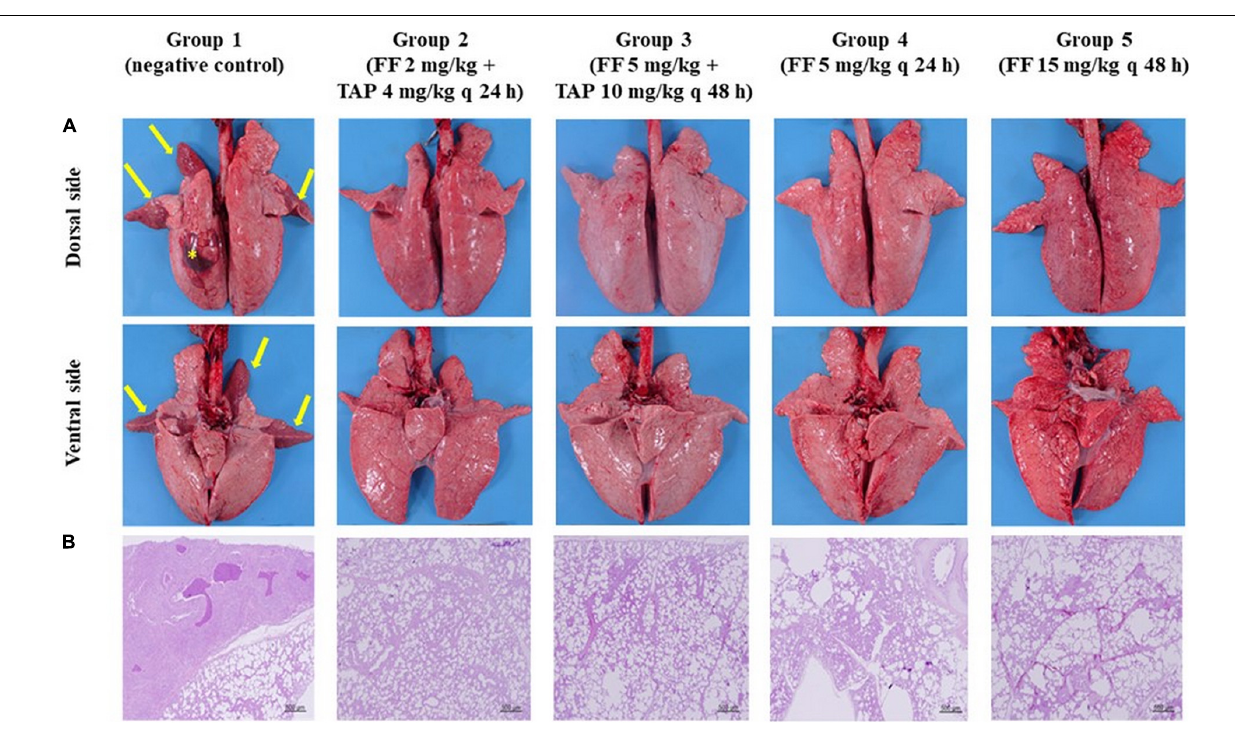
combined with 1/4 MIC of TAP, a 1:2 ratio. This ratio has been reported previously to be effective in both mice and chickens (Wei et al., 2016a,b). In contrast, FF + TYL combination at a ratio of 2:1 (FF 50 mg + tylosin tartrate 25 mg per mL;